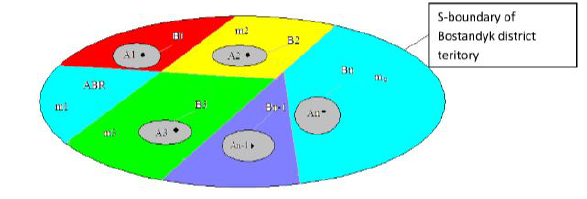
Figure 1: Scheme of ecological zones in ABR area with a boundary S with enterprises and